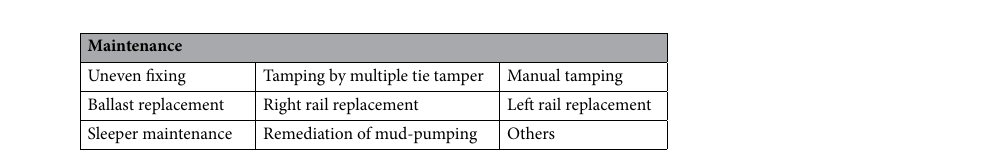
Table 4. Maintenance operations for vertical alignment